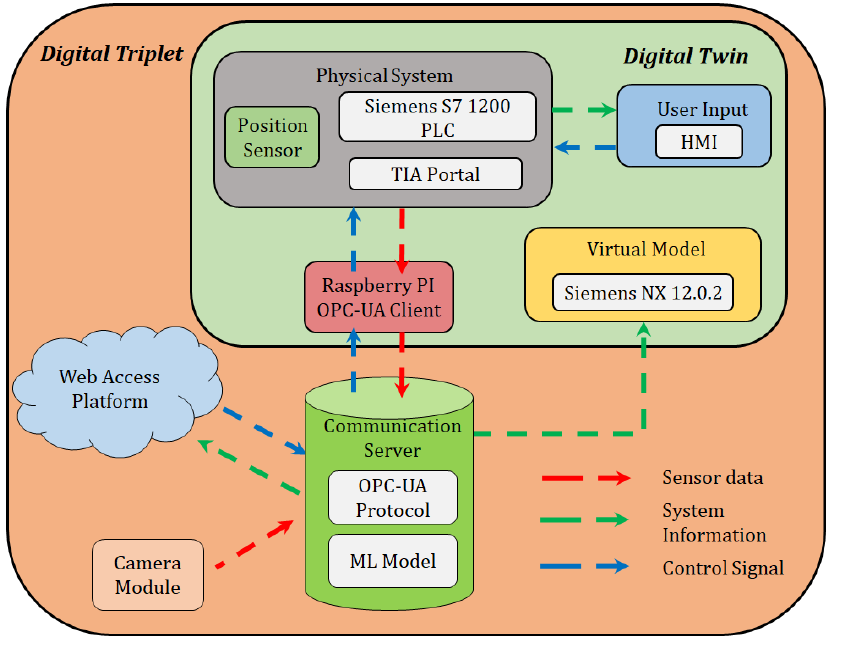
Figure 5. Block diagram of Digital Triplet system